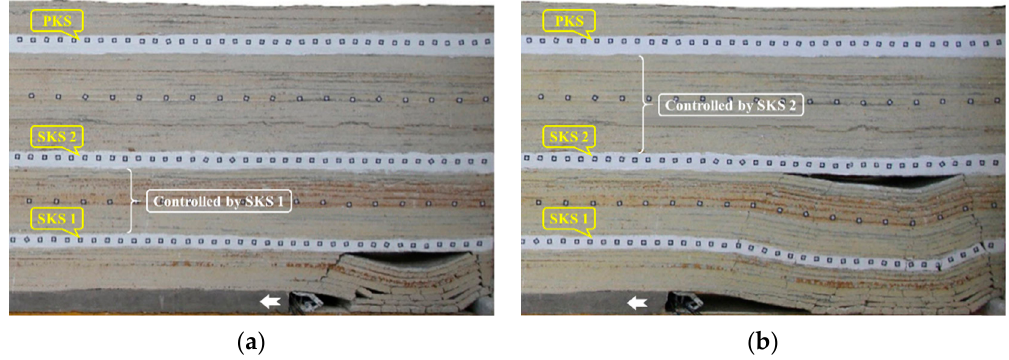
Figure 1. Control effect of key strata (KS) in overlying strata movement; ( a ) the control effect of sub- Figure 1. Control e ff ect of key strata (KS) in overlying strata movement; ( a ) the control e ff ect of sub-key key strata 1 (SKS1) from the SKS1 roof to the SKS2 floor; ( b ) the control effect of SKS2 from the SKS2 strata 1 (SKS1) from the SKS1 roof to the SKS2 floor; ( b ) the control e ff ect of SKS2 from the SKS2 roof to the primary KS (PKS) roof to the primary KS (PKS) floor.